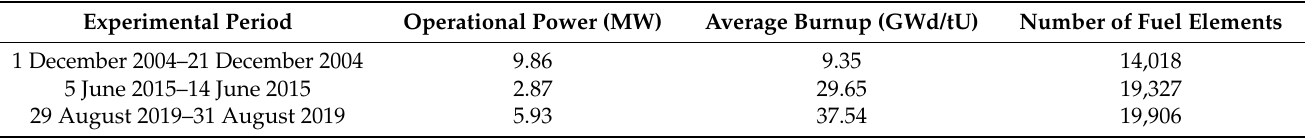
Table 6. Experiments in the primary loop of